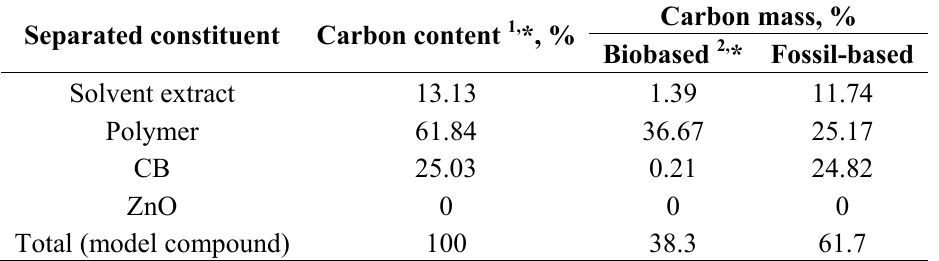
Table 10. Calculated biobased and fossil-based carbon masses for separated constituents.